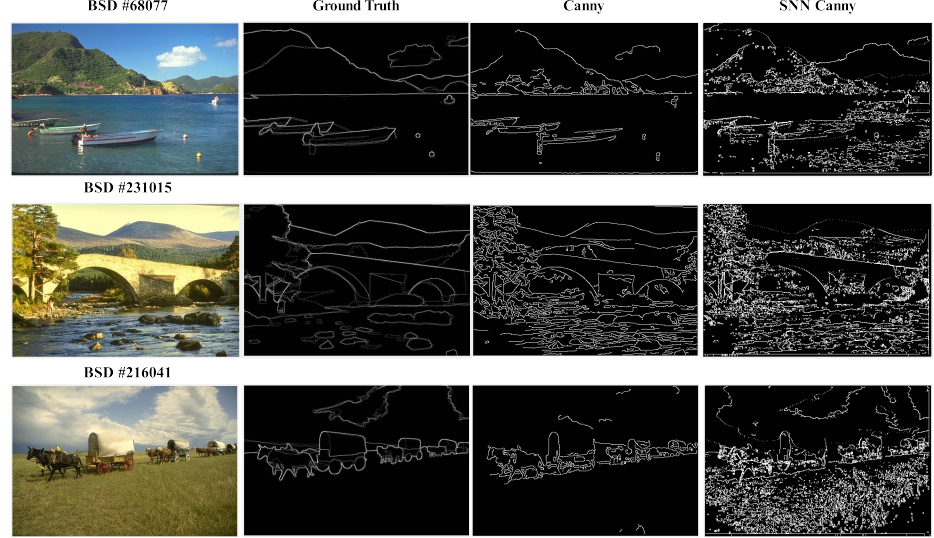
Figure 4. A comparison of the ground truth with the results from Canny edge detector and the SNN analogue of Canny edge detector for selected images from BSD500 dataset. For these images, the metrics for SNN Canny edge detector come out lower compared to the Canny edge